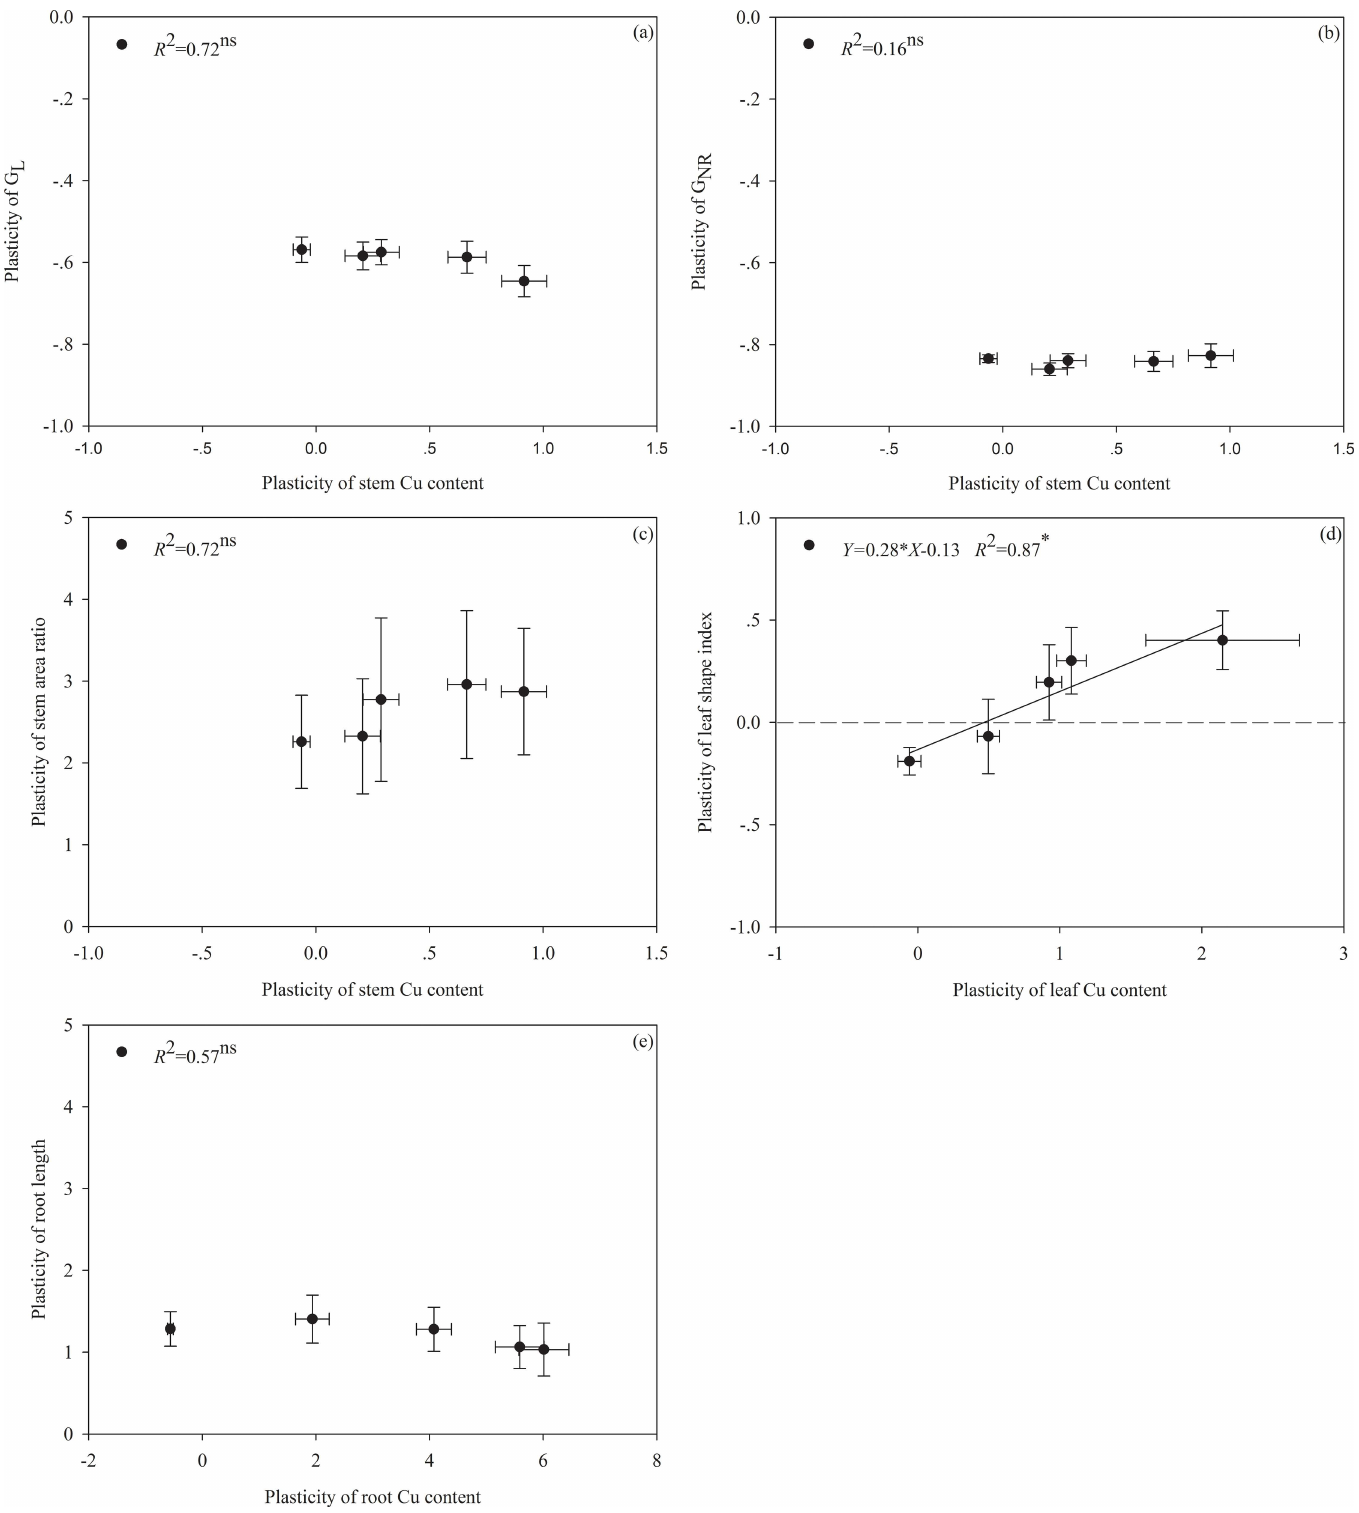
Fig 4. Relationship between the plasticity of the mean stem Cu content of the plants throughout the entire experiment and the plasticity of the mean growth rate of the total length (G L ) (a), mean growth rate of new ramets (G NR ) (b), stem area ratio (c), leaf shape index (d) and root length (e);between the plasticity of the mean leaf Cu content and the plasticity of the leaf shape index; and between the plasticity of the mean root Cu content and the plasticity of root